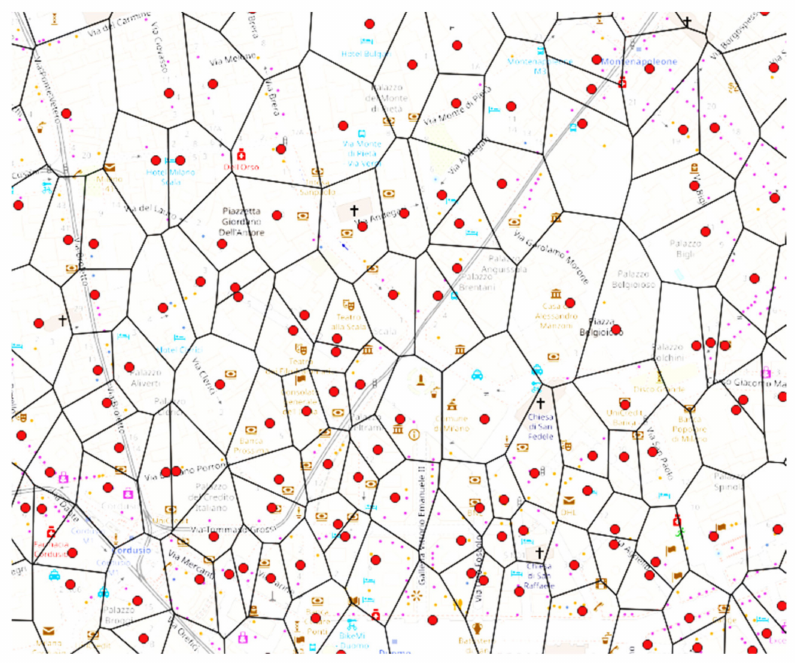
Figure 2. Voronoi polygons for some of the secondary substations under